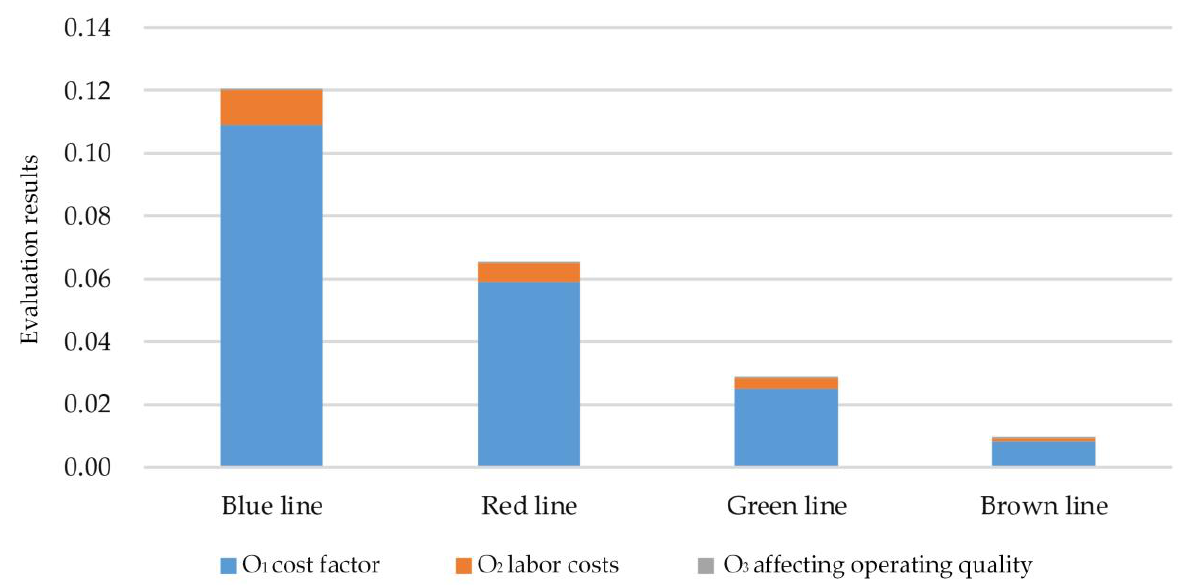
Figure 9. The weights of evaluation factors in the 2nd layer of the blue line, red line, green line, and brown line.